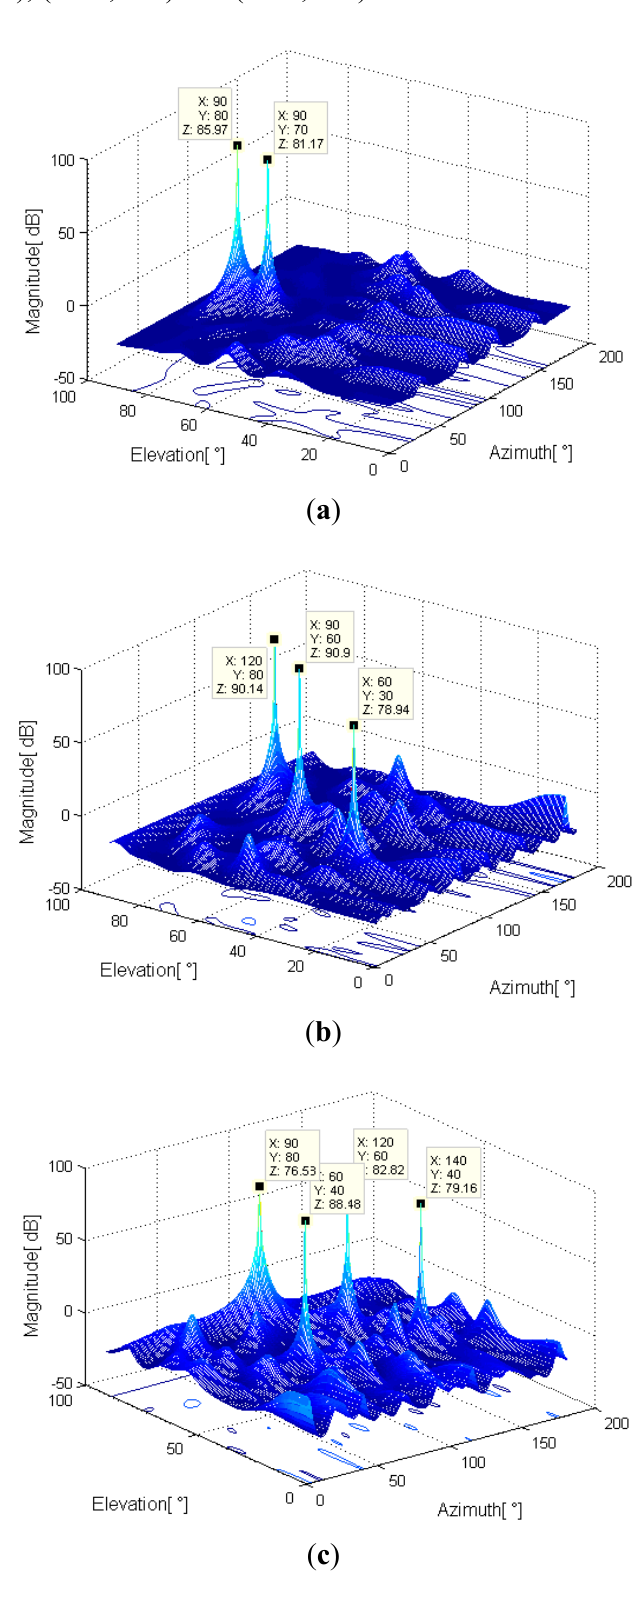
Figure 3. Spatial spectrum with multiple signals. ( a ) Two signal DOAs are (90°, 70°) and (90°, 80°); ( b ) Three DOAs are (60°, 30°), ( 90°, 60°) and ( 120°, 80°); ( c ) Four DOAs